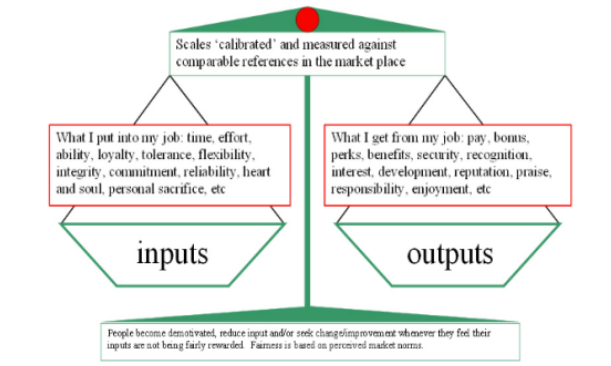
Figure 1: Diagram Equity Theory ; Source: Redmond,